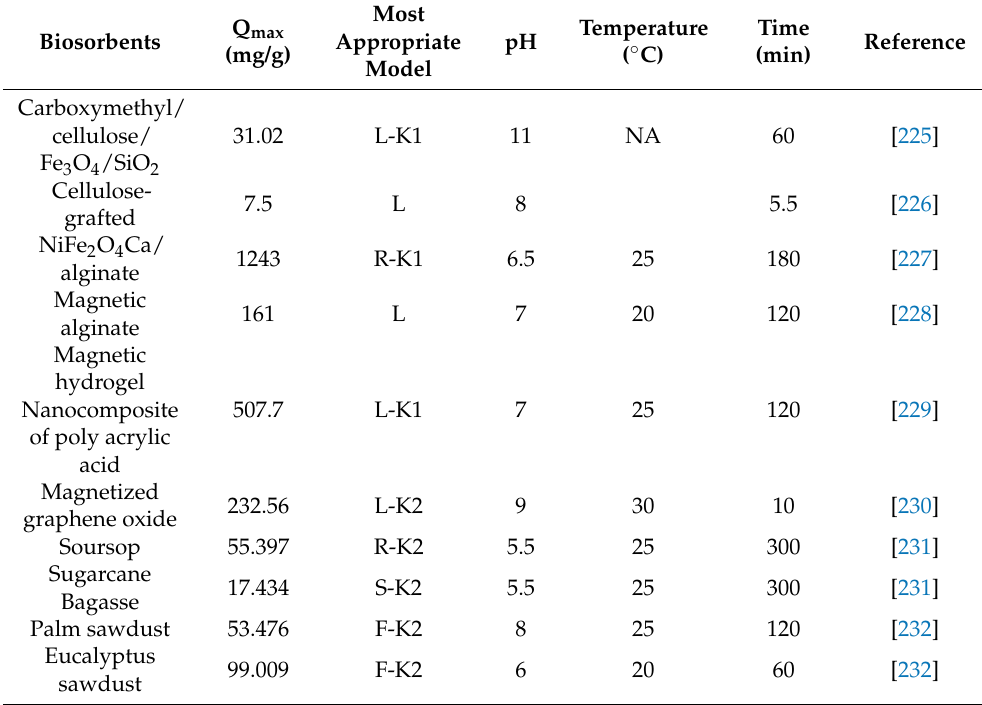
Table 10. Summary of bio-waste-derived adsorbent studies in